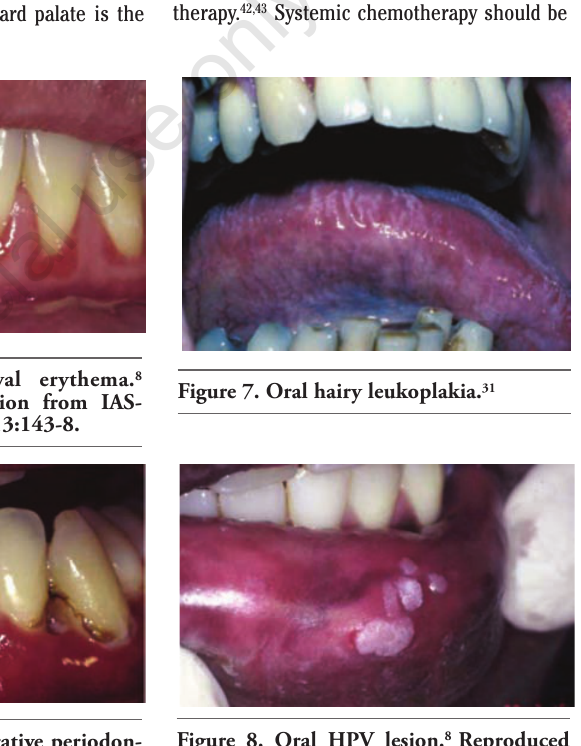
Figure 5. Necrotizing ulcerative periodon- titis. 8 Reproduced with permission from IAS-USA. Top HIV Med 2005;13:143-8.